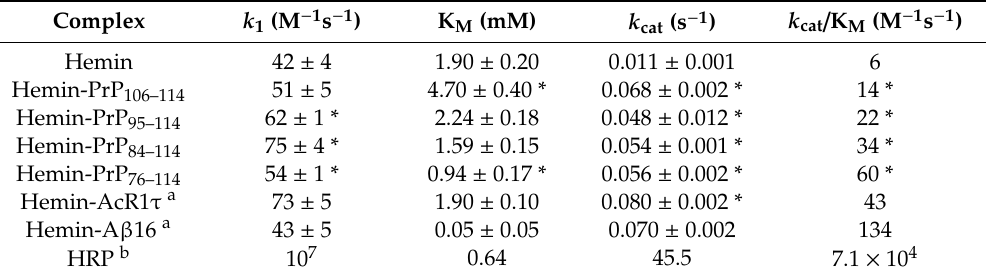
Table 2. Kinetic parameters for the catalytic activity of the hemin and hemin-peptide complexes in the oxidation of ABTS by hydrogen peroxide, in phosphate bu ff er, pH 7.4, at 25 ◦ C.